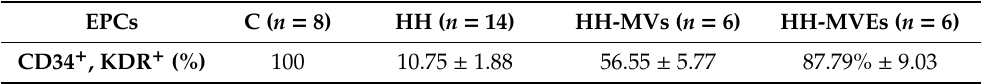
Table 5. Quantification (in percentages of control) of circulating endothelial progenitor cells (EPCs) (CD34 + , KDR + ) by flow cytometry analysis, as a biomarker of cardiovascular disease after 4 months of the hyperlipemic–hypertensive diet and MV / MVE